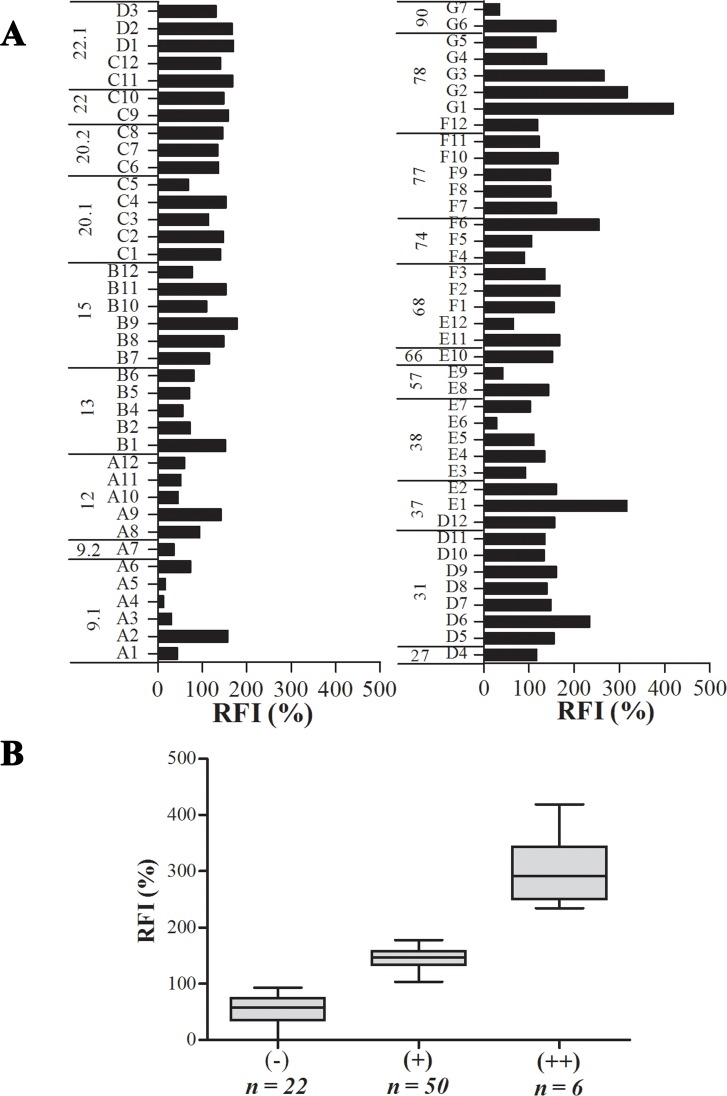
Binding affinity of LmES peptides to HLA-A*0201 molecules.The affinities of selected peptides were determined by class I HLA stabilization assay. (A) Results for individual peptides. T2 cells were initially incubated with 100μg (final concentration) of each of the peptides/mL for 16h at 37°C, followed by incubation at 37°C for 2h in presence of Brefeldine A. HLA-A2 expression on these cells was analyzed by flow cytometry using the BB7.2 antibody. MHC stabilization efficiency for each peptide was calculated as the percentage increase of the mean fluorescence above that of the negative controls. Results were expressed as relative fluorescence intensity (RFI). (B) Box plot results. ++: RFI ranges from 200 to 300%, +: RFI ranges from 100 to 200%, and -: RFI ranges from 0 to 100%.